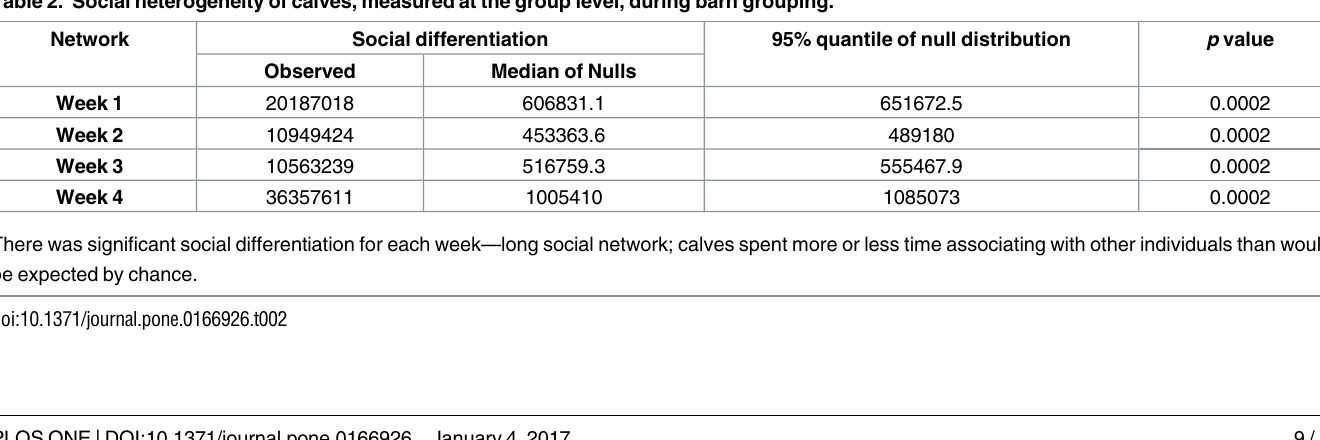
Barn grouping Network stability. All week-long association matrices were significantly positively corre- lated, indicating a degree of stability in the calves’ network (Table 1). The R squared value for the correlation between weeks one and four suggests around 50% of the network was stable from the start to the end of the month. Social differentiation. In each week—long social network there was significant social dif- ferentiation (Table 2) which demonstrates that calves associated non-uniformly, spending more or less time with other individuals than would be expected by chance. Assortment. There was significant assortment by familiarity in week one (posterior mean = 1.417, p < 0.001, DIC = 4490.49) and week four (post. mean = 1.037, p < 0.001, DIC = 4664.901); calves spent more time with those they were more familiar with (in terms of duration of full social contact). Calves were not significantly assorted by treatment in week one (post. mean = -2.97, p = 0.076, DIC = 4876.727) or week four (post. Mean = -2.124, p = 0.2, DIC = 4876.406). The posterior mean refers to the mean of the posterior distribution, as gener- ated by the Bayesian model for the given parameter and is indicative of effect size. Between-treatment differences in coefficient of variation (CV) in association strength. There was a significant difference in CV in association strength between treatments during week one (F( ) = 5.238, p = 0.011; Fig 2a). A Bonferroni post hoc test revealed that P5 2,34 calves had significantly higher CV in association strength than I calves. However, there were no significant differences in CV in association strength between treatments during week four (F( ) = 1.883, p = 0.169; Fig 2b). After omitting the duration of time that calves spent with 2,34 Table 2. Social heterogeneity of calves, measuredat the group level, during barn grouping. Network Social differentiation 95% quantile of null distribution Median of Nulls